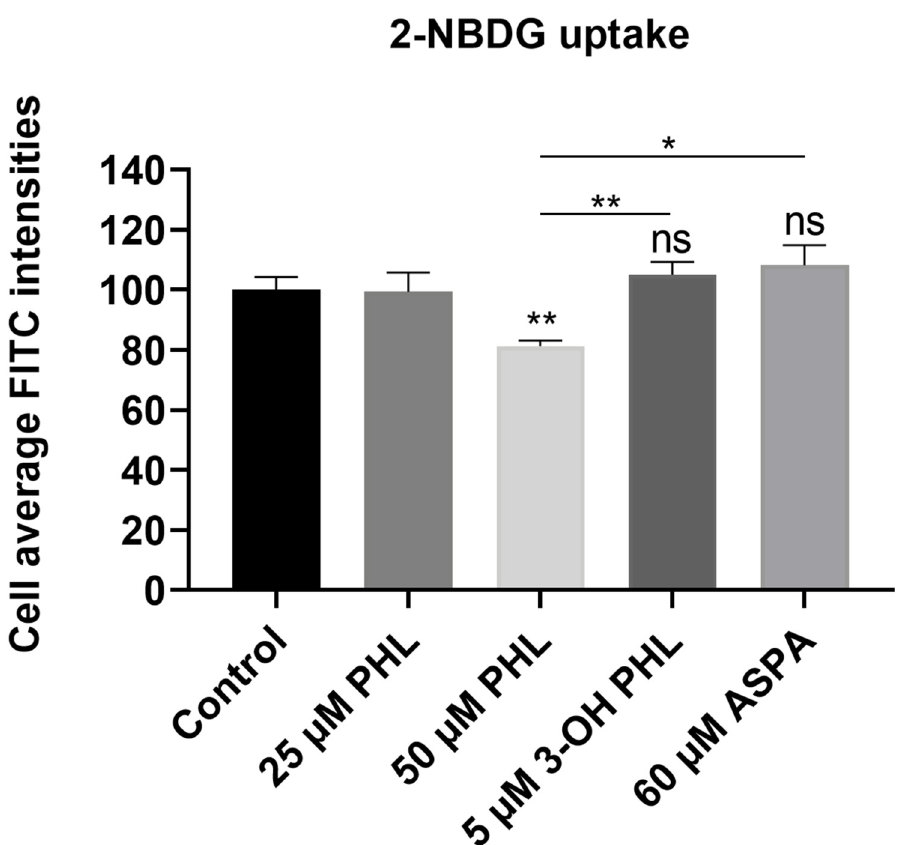
Fig 5. Uptake of fluorescent glucose-analog 2-NBDG. INS1E β cells were exposed to 25 and 50 μ M phloretin (PHL; positive control), 5 μ M 3-hydroxyphloretin (3-OH PHL) and 60 μ M aspalathin (ASPA). Glucose uptake was measured using the ImageXpress Pico Automated Cell Imaging System and quantified with the CellReporterXpress Image Acquisition and Analysis Software. Differences between groups were analysed by paired One-way ANOVA with Sidak’s multiple comparisons test. Results represent average of 8 independent plates ± SEM. Non-significant results are indicated by ns, � p < 0.05 and �� p <